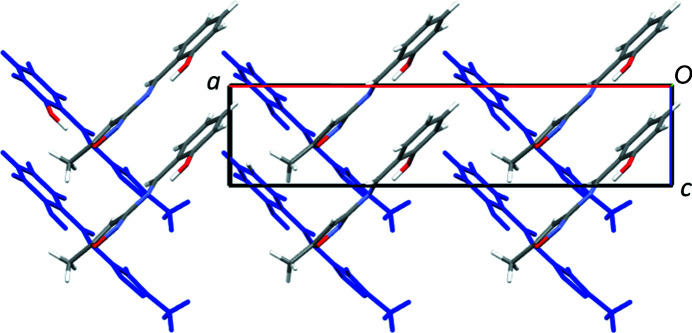
Illustration of the packing in 2, looking down the b axis. Mol­ecules are shown in elemental colours (C grey, O red, N blue and H white) at the front, while mol­ecules shown in blue are one mol­ecule down the b axis, showing the different orientations.